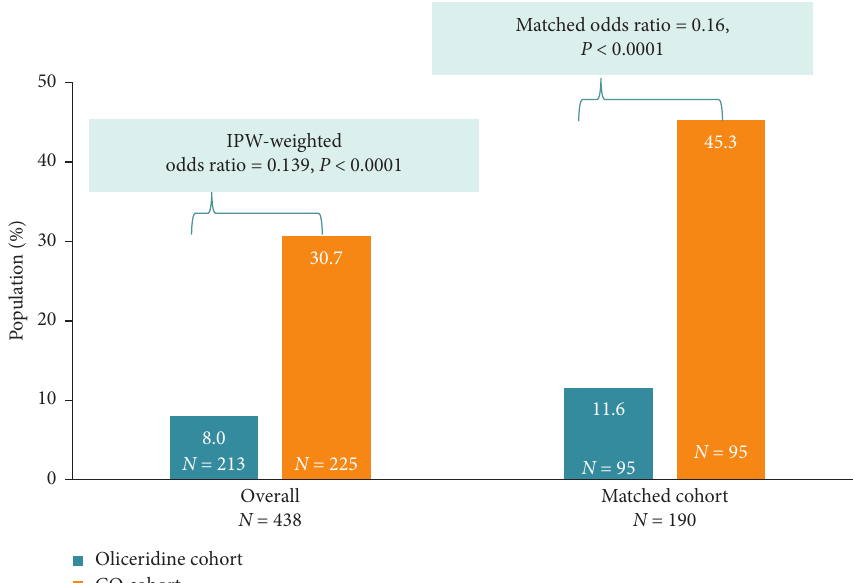
Figure 3: Incidence of opioid-induced respiratory depression (primary outcome). Using the Inverse probability weighting (IPW) approach patients in the CO cohort were balanced with those in the oliceridine cohort in several prespecified characteristics, including age, sex, site, illness comorbidities, American Society of Anesthesiologists (ASA) status, and type of surgical procedure. The IPW approach weights patient observations based on a propensity score, which is defined as the weighted probability of a patient belonging to a specific cohort. Propensity scores were estimated using a multivariate logistic regression model conditional on the observed baseline covariates (surgical procedure type, ASA status, age, sex, race [characterized as white/nonwhite], and BMI). Matched cohort consisted of 95 subjects in either cohort with a direct one-to-one (1:1) matching approach on the same observed matching variables used in the complete IPW balanced sample. For the oliceridine cohort, OIRD events were prespecified, as defined in the original study protocol for all patients based on verbatim clinical terms coded using adverse event methodology defined in MedDRA reporting terminology (MedDRA, version 19.0). For the CO cohort, ICD-9 and ICD-10 codes were obtained as recorded in each patient’s chart review and entered into their accompanying Electronic Medical Record (EMR). A total of 206 patients (91.6%) in the CO cohort received other opioids concomitantly or after treatment with IV morphine. Incidence of respiratory events was significantly lower in the oliceridine